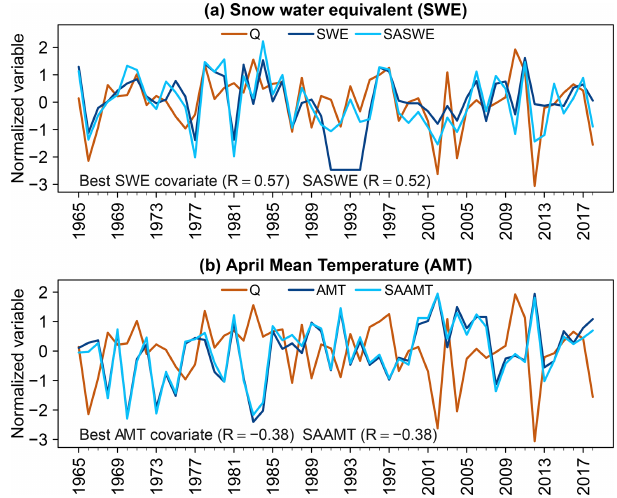
Figure 5. Time series of normalized 3d spring maximum stream- flow, best covariate, and the spatial average covariate of (a) accu- mulated snow water equivalent until 30 April (SWE) and (b) mean April temperature (AMT) for UCRB1. At the bottom of each panel, the correlation of 3d maximum streamflow with the regional and the best local (i.e., highest correlation) covariate are